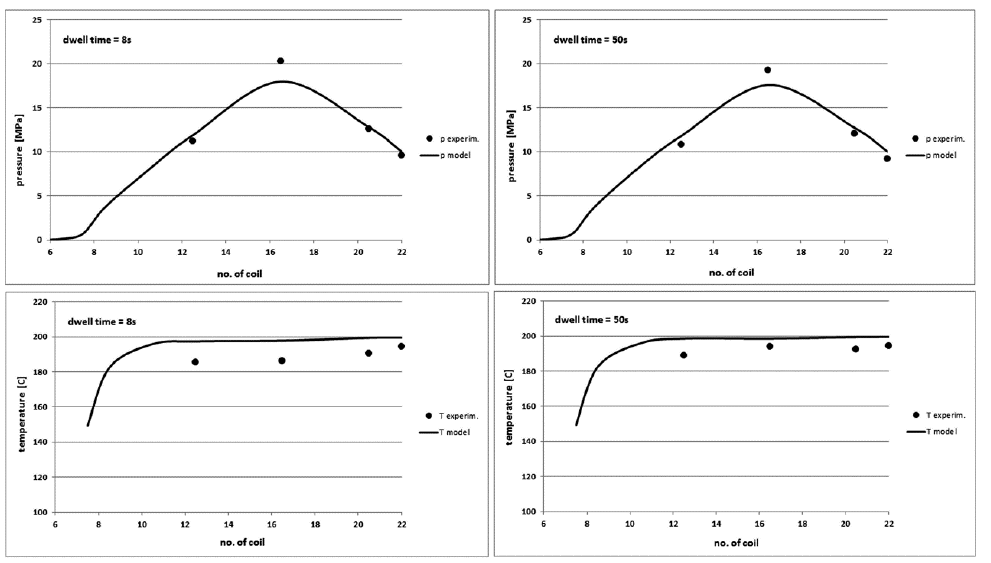
Figure 12. Comparison of theoretical and experimental characteristics of pressure ( top ) and temperature profiles ( bottom ) on the screw channel length in PE-HD injection process for the dwell time of 8 s ( left ) and 50 s ( right ).